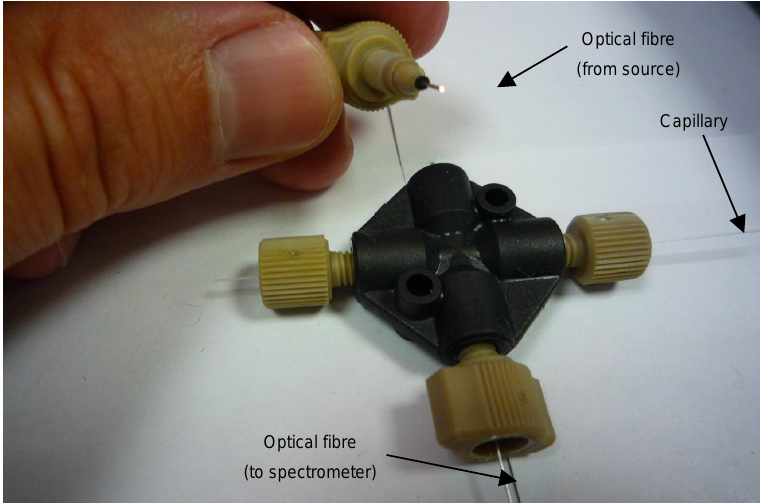
Figure 2. Arrangement of the initial fibre-optic and coupling assembly for the in-process measurement of polymer layer thickness. The black fitting is a 4-way 10/32″ microfluidic piece. The other connectors are 10/32” microfluidic connectors with 400 and 100 µ m ID sleeves (1/16” OD) for the capillary and optical fibre,